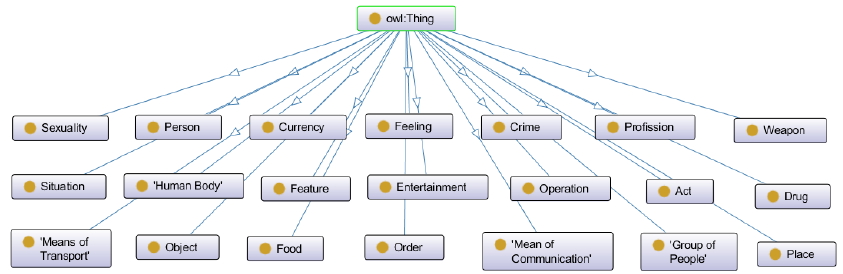
Figure 5. Overview of the main OntoCexp classes (adapted from